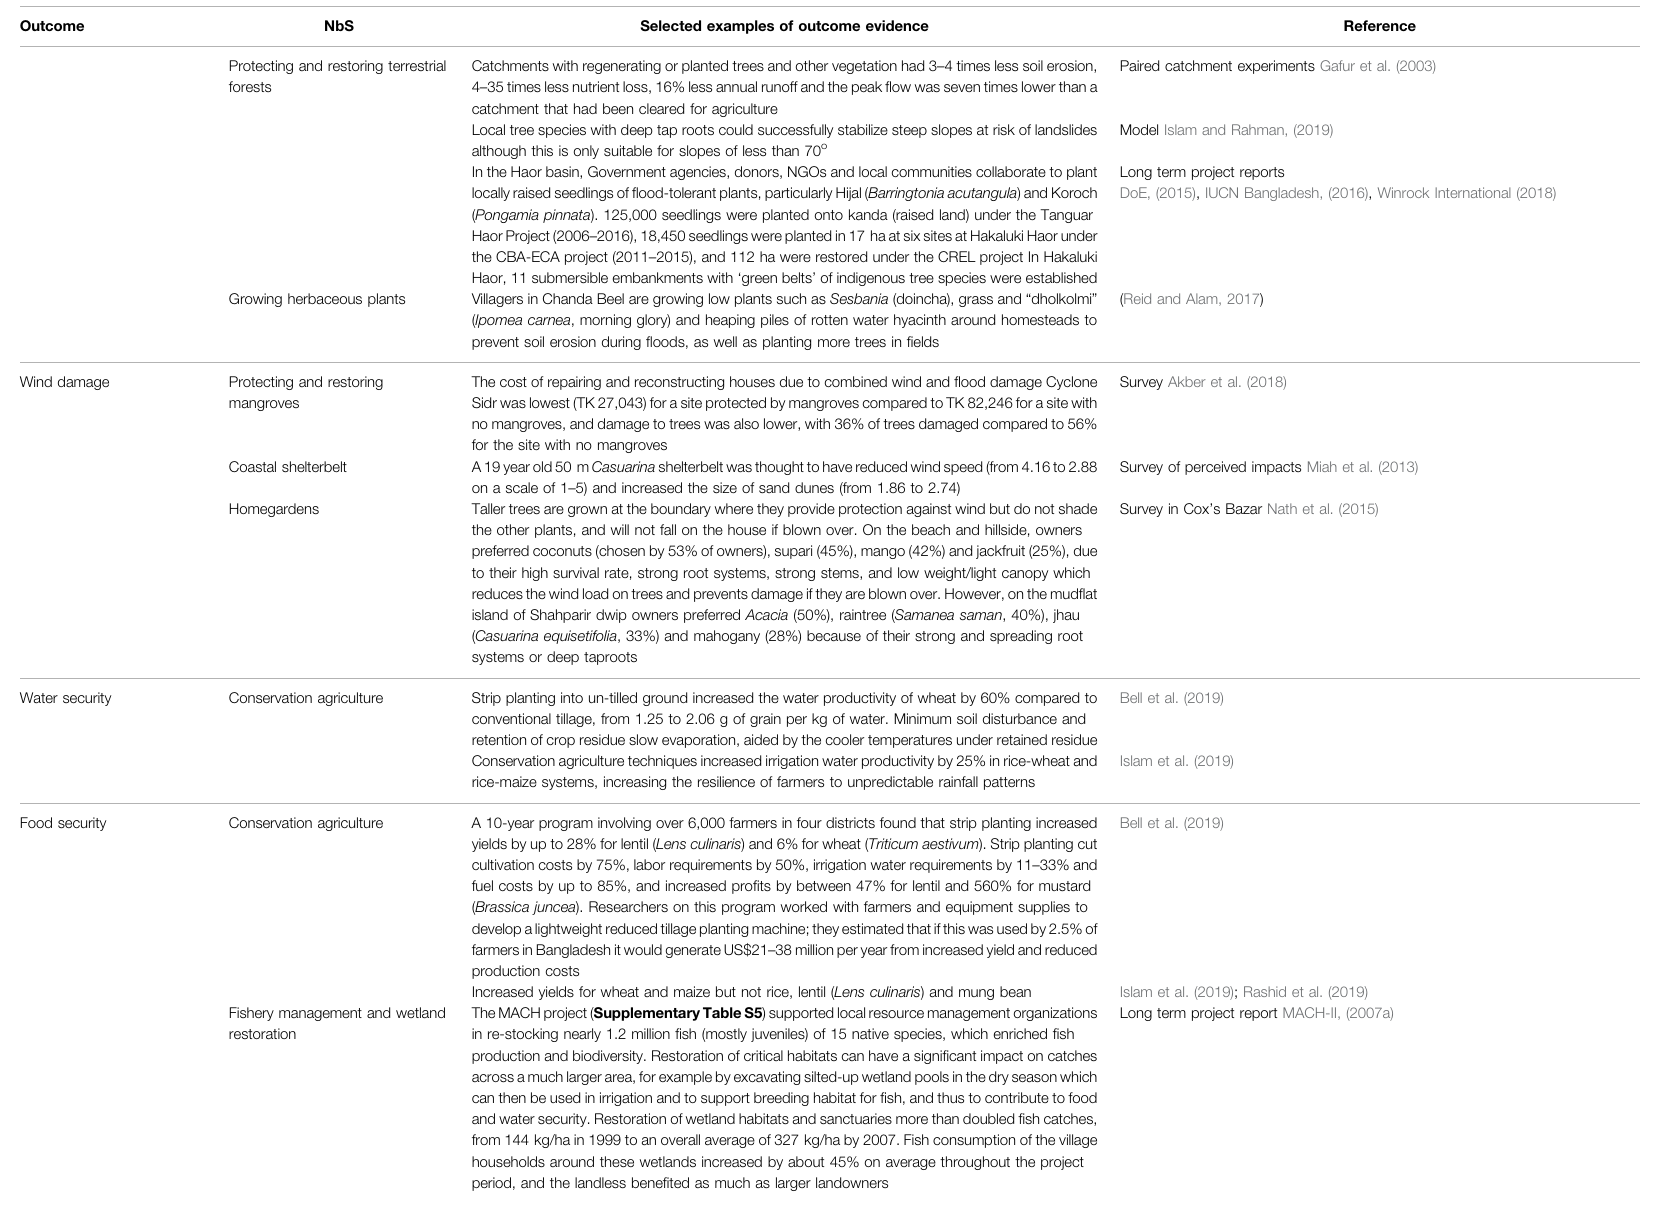
TABLE 5 | ( Continued ) Key examples of evidence on the target outcomes of NbS cited in Effectiveness of Nature-based Solutions for Addressing the Target